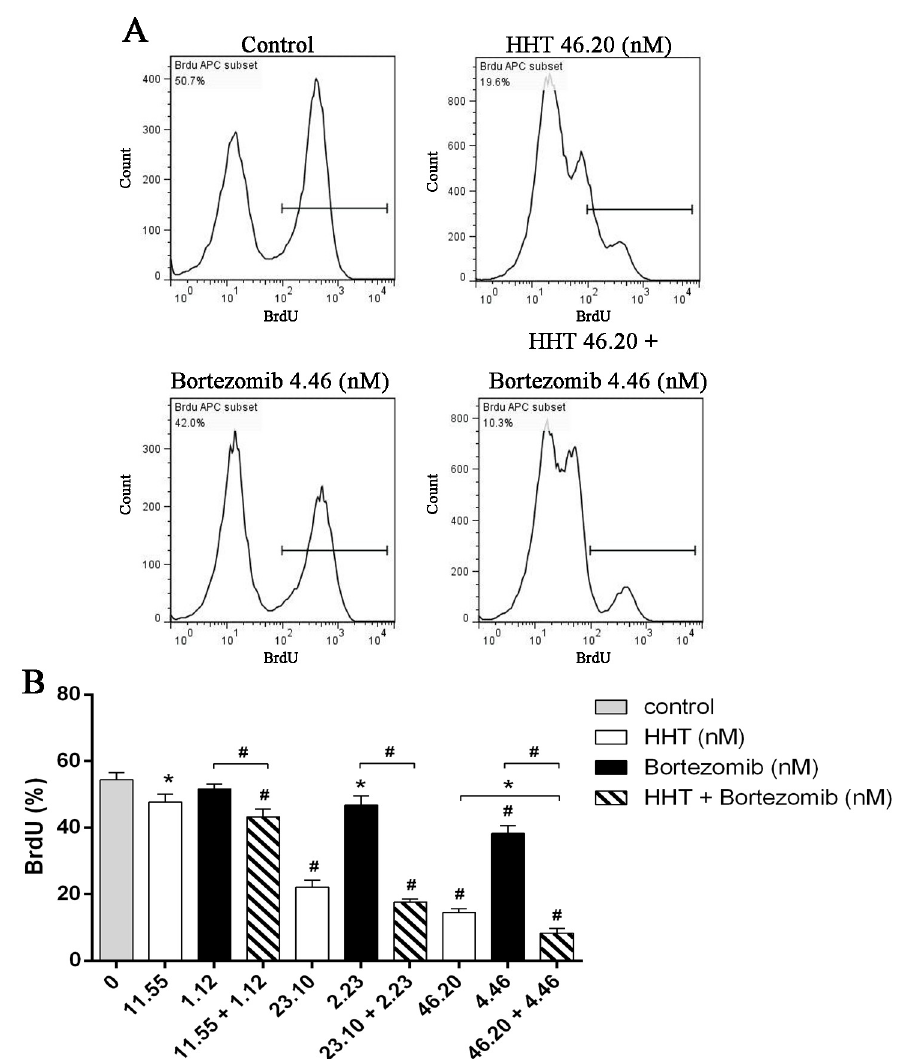
Fig 2. Simultaneous exposure to HHT and Bortezomib resulted in a significant reduction of cell proliferation. (A) SKM-1 cells treated with 46.20 nM HHT, 4.46 nM Bortezomib or 46.20 nM HHT + 4.46 nM Bortezomib simultaneously for 72 h. (B) SKM-1 cells treated with HHT (11.55, 23.10, 46.20 nM) or Bortezomib (1.12, 2.23, 4.46 nM) for 72 h. Concurrently, simultaneous treatment experiments were conducted at molar ratio of 10.4: 1. Bar graph of BrdU positive rates. * P < 0.05, #P < 0.01 vs untreated